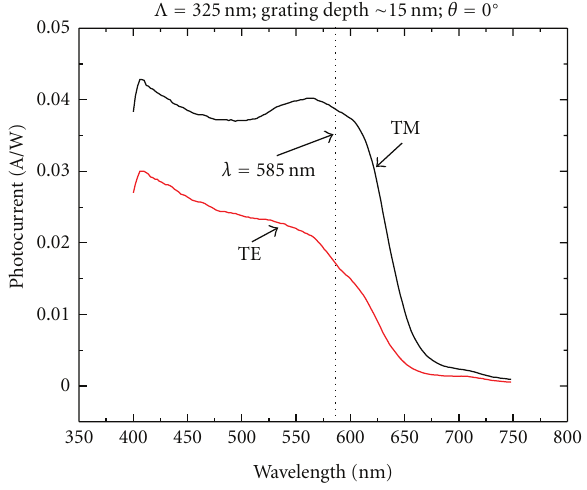
Figure 8: The dispersion relation plot for gratings with Λ = 250nm and various depths.